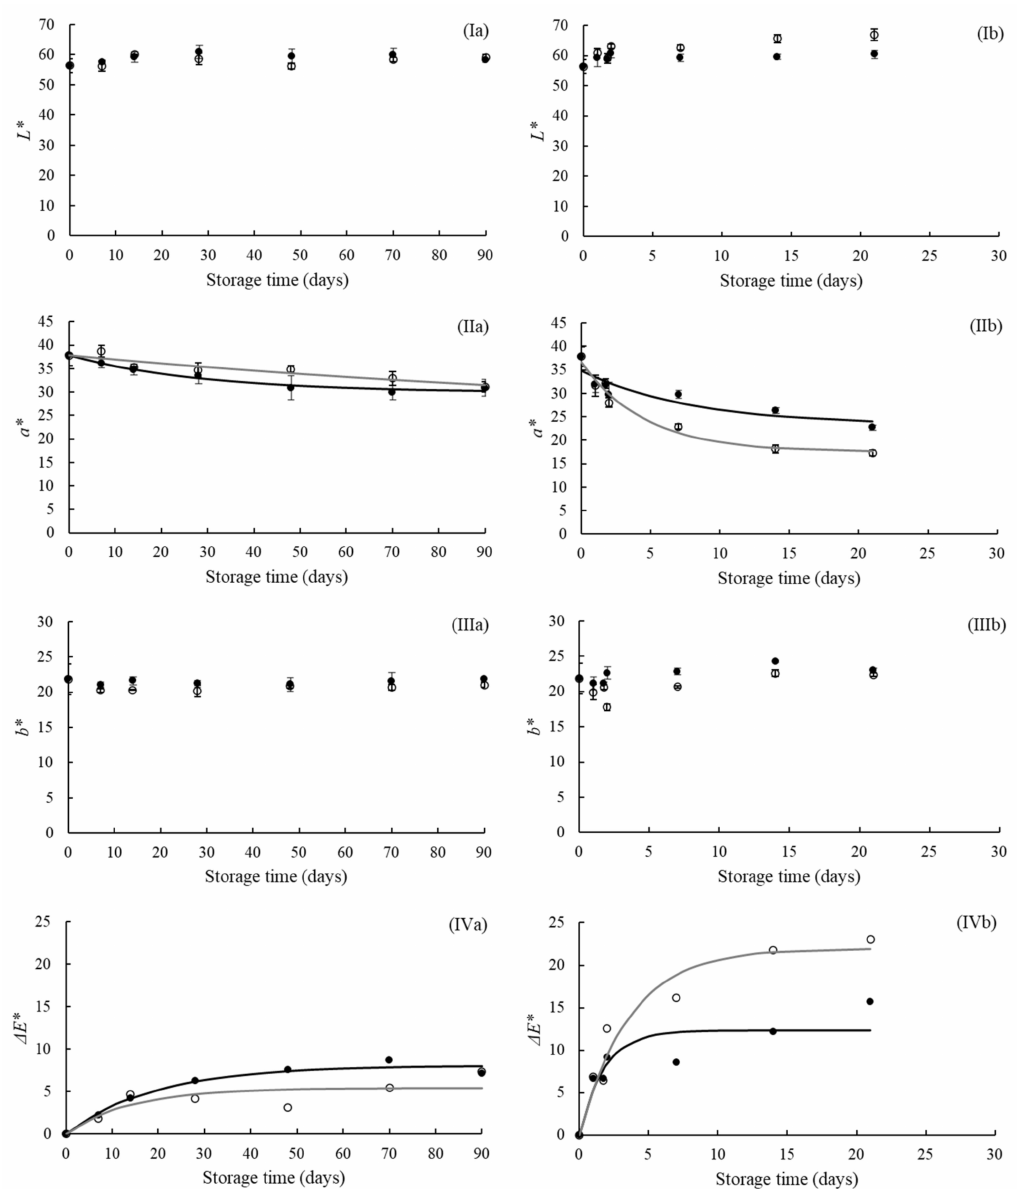
Figure 2. Evolution of color parameters ( L* ( I ), a* ( II ), and b* ( III )) and total color difference ( ∆ E* ( IV )) of the strawberry leather during storage at 22.5% RH ( a ) and 52.3% RH ( b ), with no illumination ( • ) and with illumination ( ). The filled and empty symbols represent experimental data. The full (cid:35) lines represent the first-order fractional conversion